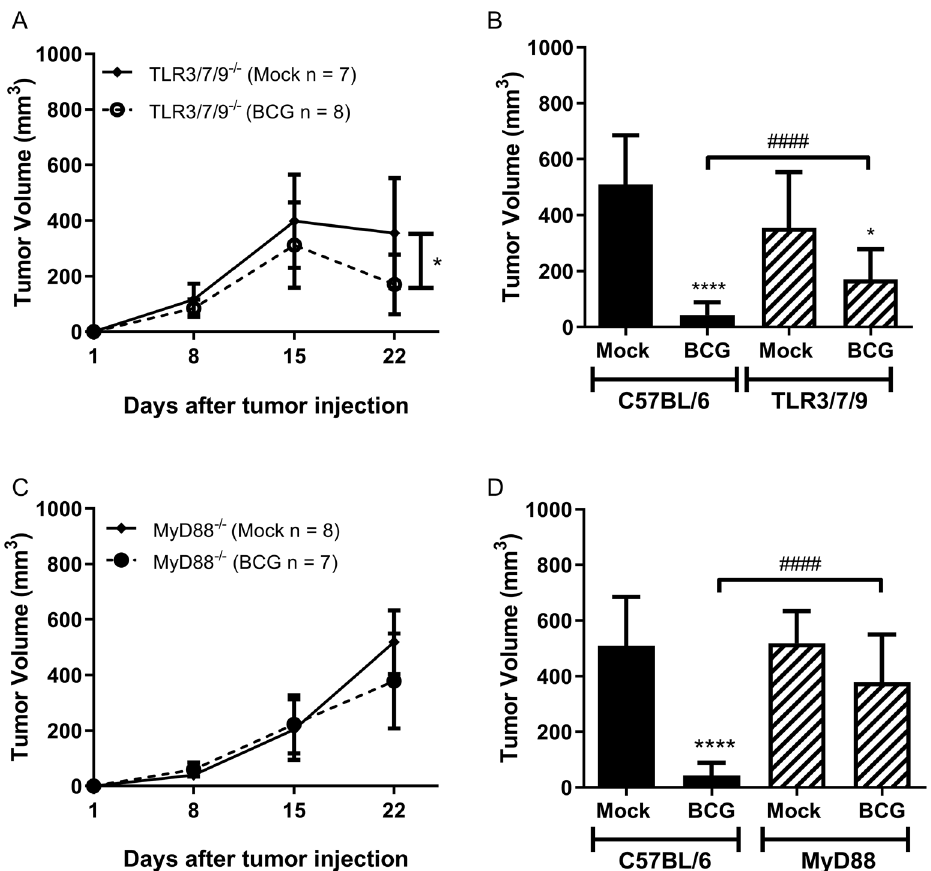
Figure 6. Tumor treatment with BCG is partially dependent on a synergistic effect of endosomal TLRs and totally dependent on MyD88 signaling. Triple deficient animals TLR3/7/9 −/− were used to evaluate the synergistic effect of endosomal TLRs and MyD88 −/− deficient mice used to define the role of this adaptor molecule in tumor regression. Mice were submitted to the subcutaneous tumor model and BCG treatment. Tumor growth curves and the final volumes (day 22) are shown for TLR3/7/9 −/− ( A , B ) and MyD88 −/− ( C , D ). Data represents mean and standard deviation from the results of at least two independent experiments. C57BL/6 WT data represents the summary of control animals from all in vivo experiments comparing WT and KO mice. *Statistically significant compared to the respective untreated control, * P < 0.05, **** P ≤ 0.0001. # Statistically significant compared to BCG treated C57BL/6 WT, #### P ≤